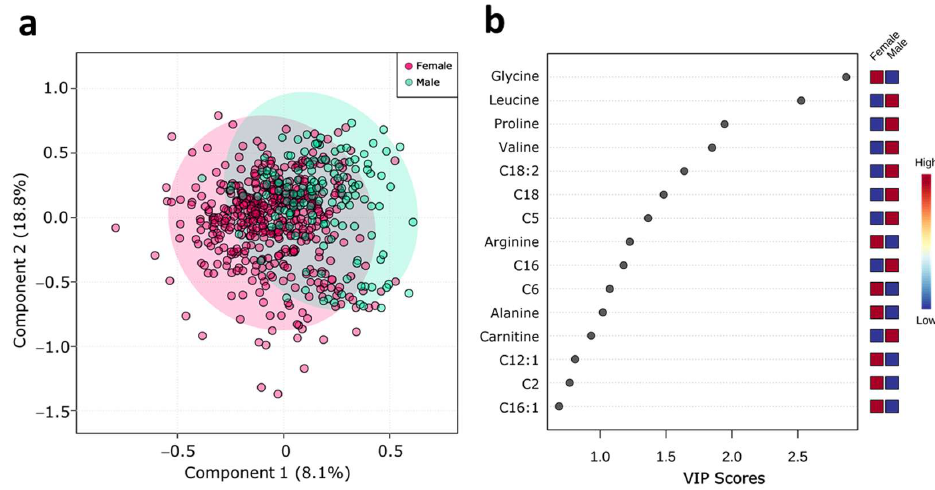
Figure 1. Serum metabolite profile according to sex. ( a ) PLS-DA plot shows separation between groups; female (red circles) and male (green circles). The explained variances are shown in brackets (accuracy: 0.80; R2: 0.24; Q2: 0.20: permutation p -value = 0.13); ( b ) VIP analysis represents the relative contribution of metabolites to the variance among groups. A high VIP score indicates a significant contribution of the metabolites to the group separation. Red and blue boxes indicate whether metabolite concentration is increased (red) or decreased (blue).